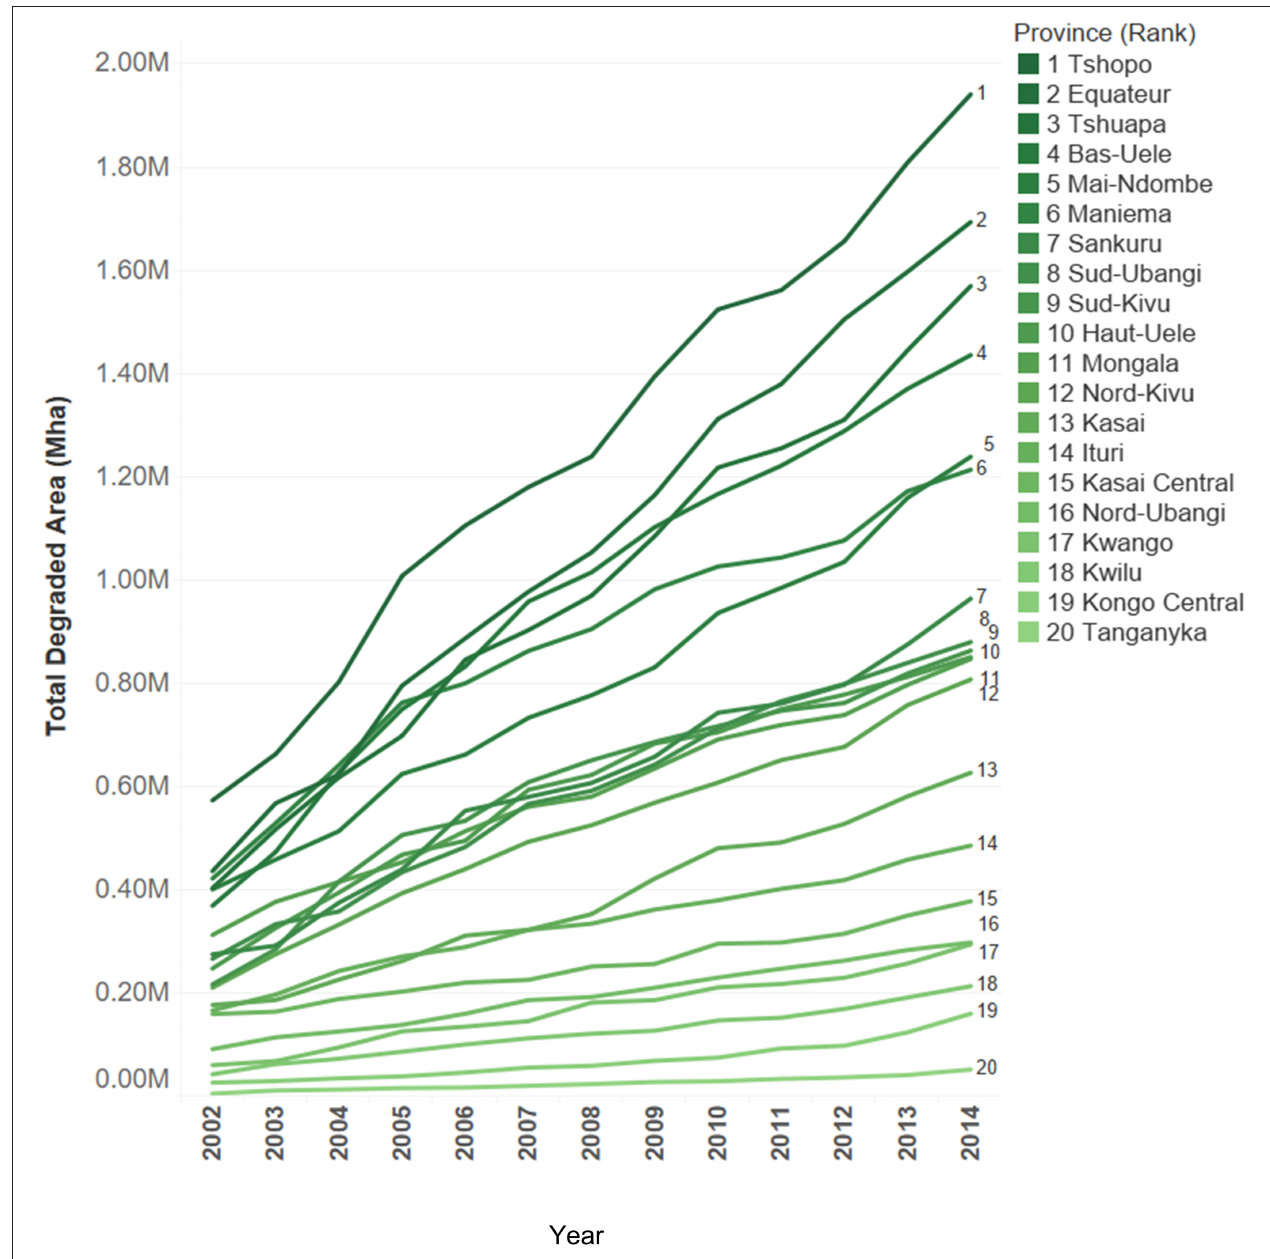
FIGURE 2 | Total degraded forest area of the 20 provinces with highest degradation rates [data from Shapiro et al. (2021)].